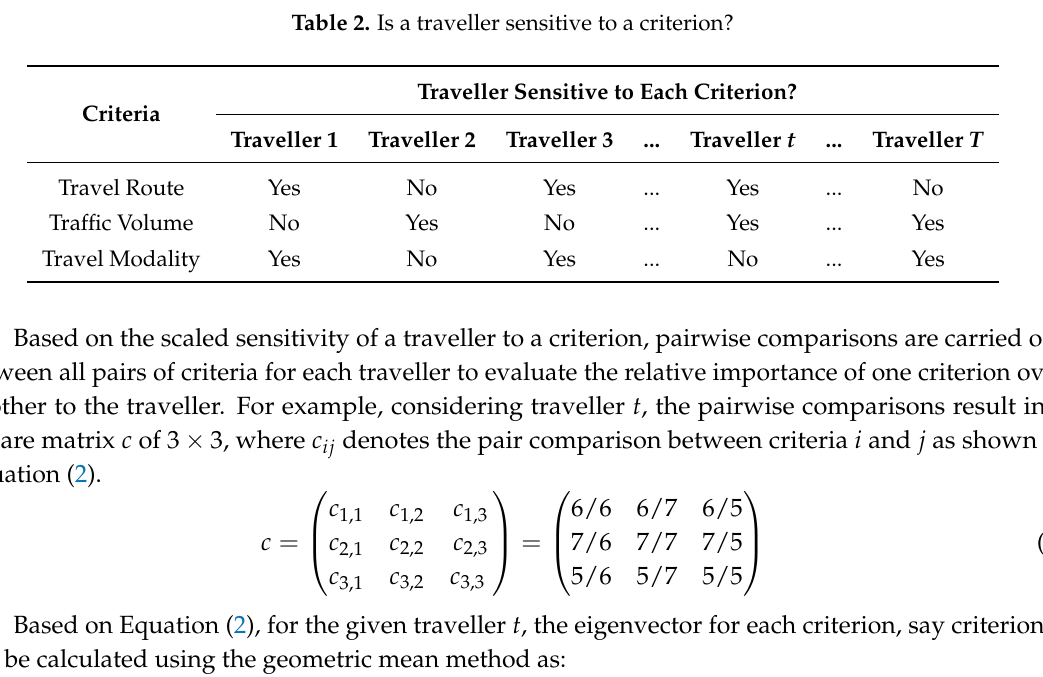
Table 2. Is a traveller sensitive to a